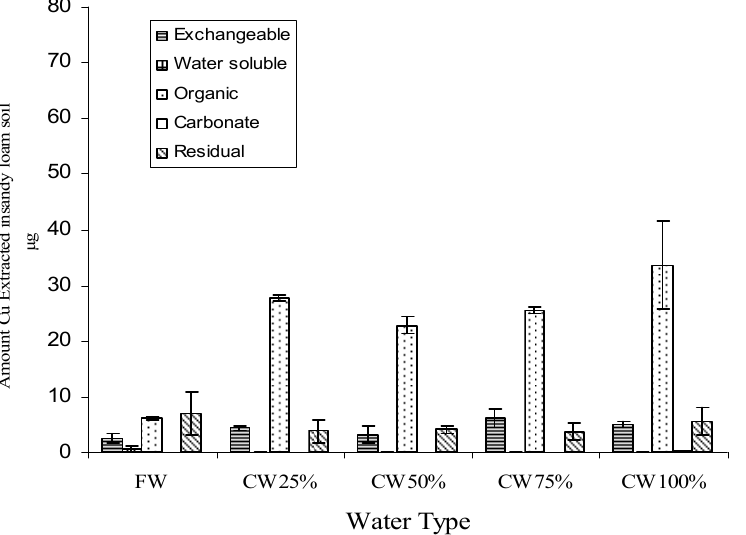
Figure 3. Mean amounts of recovered fractions of Cu (in μ g) in sandy loam soil that had been irrigated with different concentrations of contaminated water.